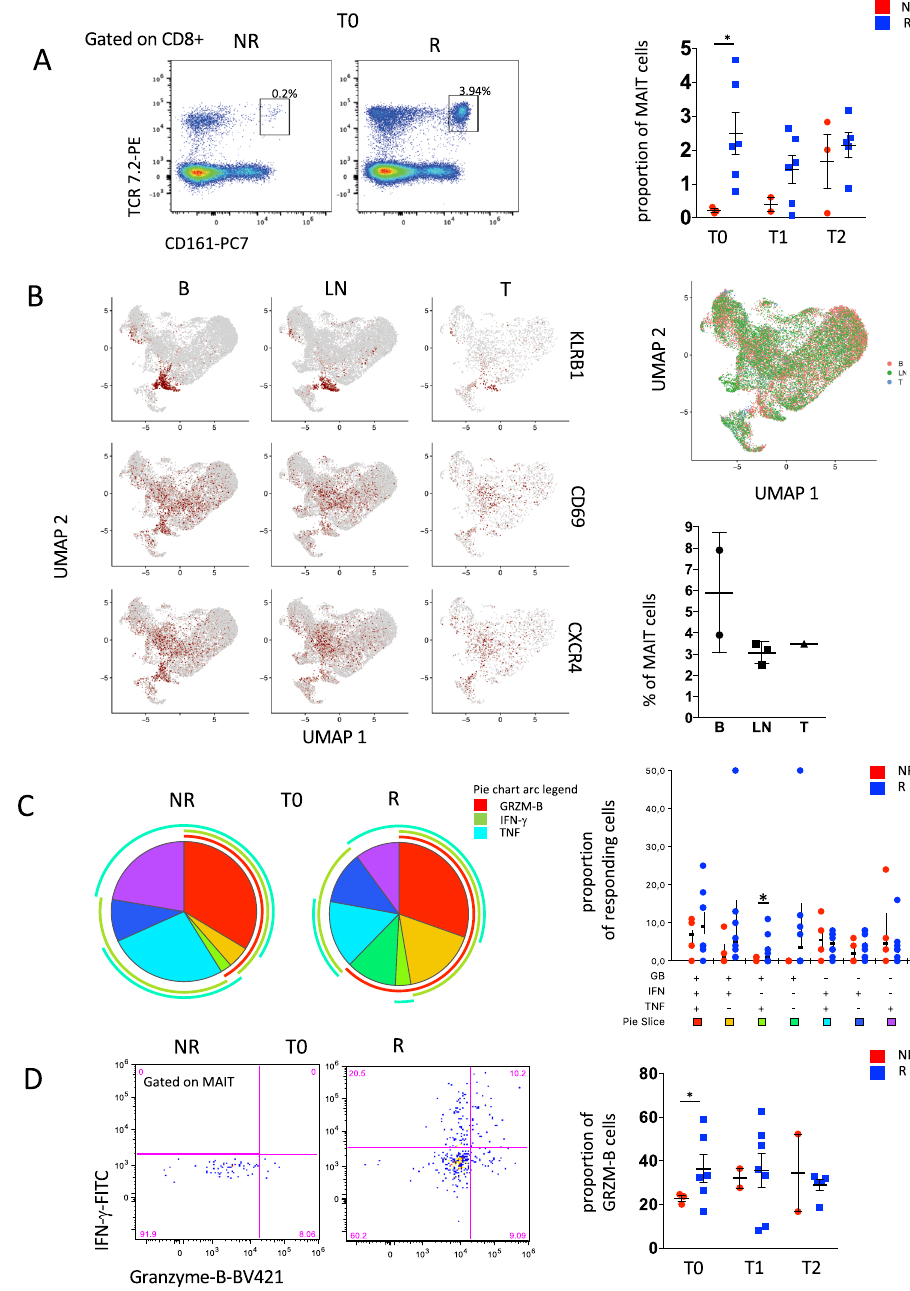
Fig. 4 MAIT polyfunctionality evaluated after in vitro stimulation in PBMC of melanoma patients. A Left and center panels: representative dot plots of MAIT cells, identi fi ed as TCR 7.2 + and CD161 + within CD8 + T cells of one R and one NR at T0. Right part: proportion of MAIT cells in R and NR at T0, T1, T2. Data represent individual values, mean (center bar) ± SEM (upper and lower bars). Statistical analysis by two-sided Mann – Whitney nonparametric test, Bonferroni ’ s multiple comparisons test. * p = 0.016. NR = 4, R = 8. B Left panel: UMAP representation of PBMC or tumor-in fi ltrating lymphocytes from patients with metastatic melanoma. Expression of KLRB1, CD69, and CXCR4 MAIT cells in blood (B), lymph nodes metastasis (LN), and Tumor (T) from the K383, K409, and K411 patients (Gene Expression Omnibus, GSE148190). Right panel: UMAP representation with the distribution of cells of B, LN and T, and proportion of MAIT in blood (B), lymphnode (LN) and tumor (T). C Left and central panels: pie charts representing the proportion of MAIT cells producing different combinations of GRZM-B, IFN γ , and TNF after stimulation at T0. Frequencies were corrected by background subtraction as determined in unstimulated controls; permutation tests (10,000 number of permutations), using SPICE software, show no difference between R and NR. Right panel: frequency of MAIT cells expressing and producing different combinations of GRZM-B, IFN- γ , and TNF after stimulation at T0. Statistical analysis by Wilcoxon rank test; * p = 0.041. In the fi gure, error bars (median value) and upper whiskers (whisker range, SEM) are represented. Individual measurements of NR = 4, R = 6. D Left and central panels: dot plots show the difference between a R and a NR in the proportion of cells that produce IFN- γ and GRZM-B at T0. Right part, proportion of MAIT cells producing GRZM-B at different time points. Data represent individual values, mean (center bar) ± SEM (upper and lower bars). * p = 0.028, Statistical analysis by Mann – Whitney nonparametric test, Bonferroni ’ s multiple comparisons test. Individual measurements of NR = 4, R = 6. Source data are provided as a Source Data fi le.